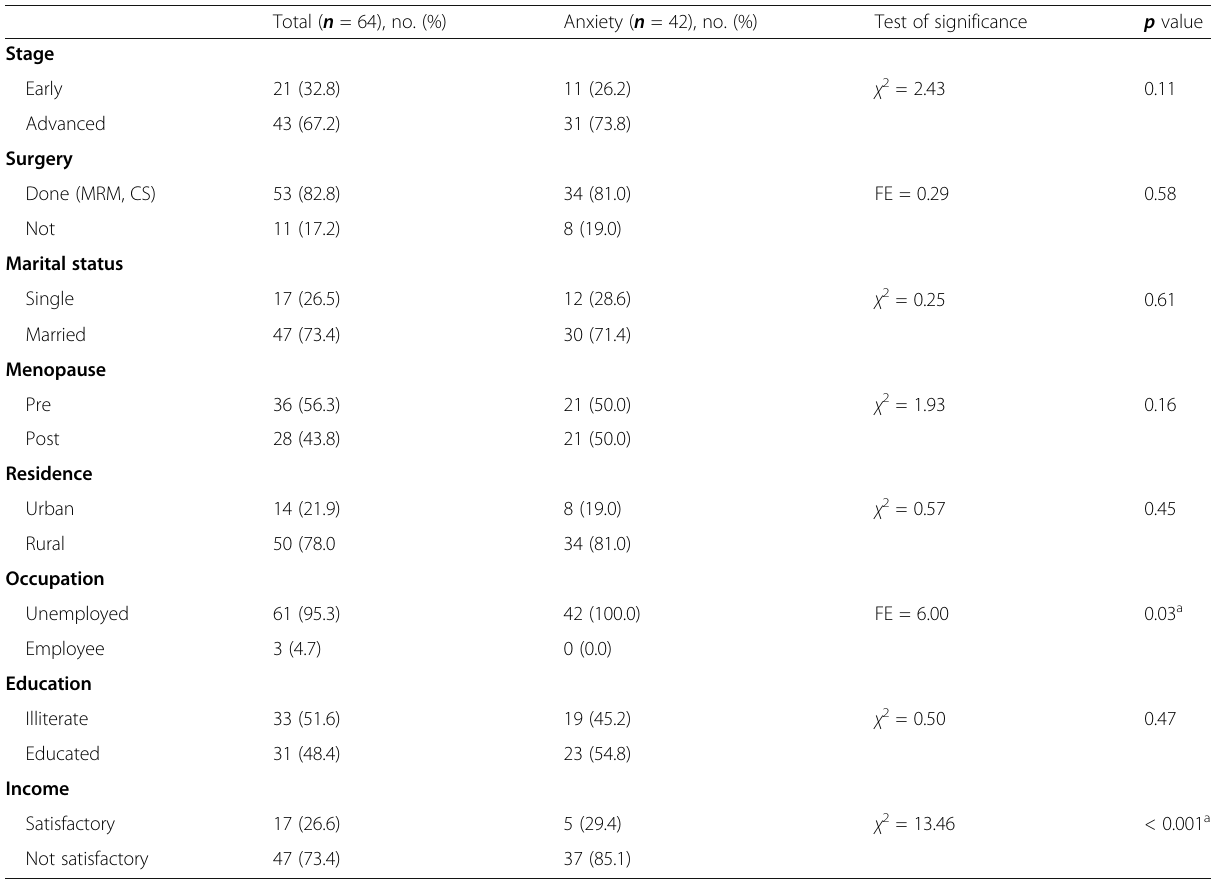
Table 4 Relationship between the total number of cases and patients with anxiety as regarding patient ’ s and disease ’ s